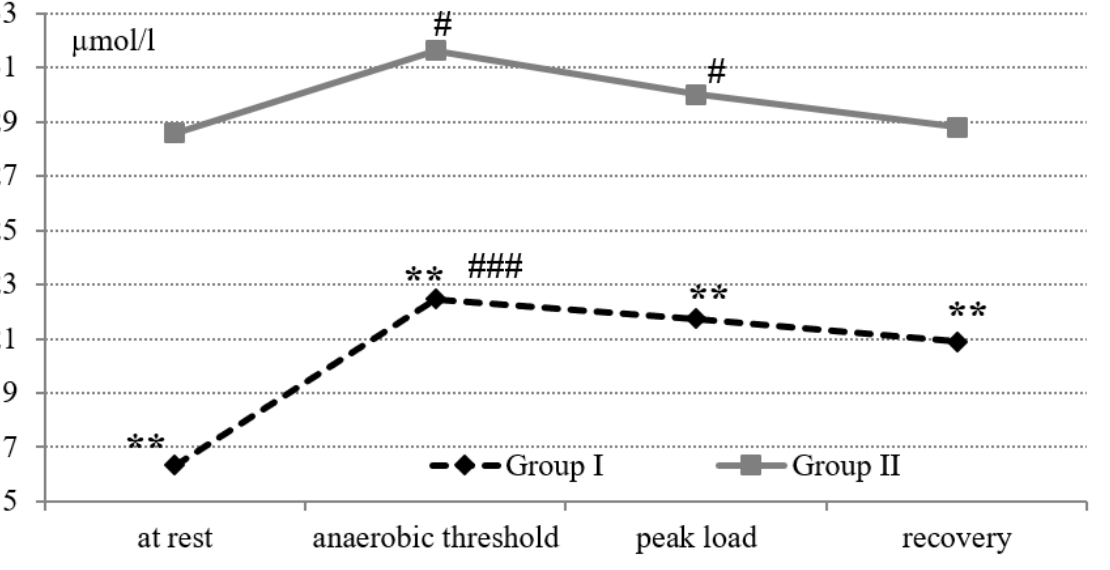
Figure 3. NO x level ( µ mol/L) during the exercise test on a cycle ergometer “until exhaustion” in cross-country skiers. Statistical significance levels between groups: ** p < 0.01. Statistical significance levels between stages of the load: # p < 0.05; ### p < 0.001.